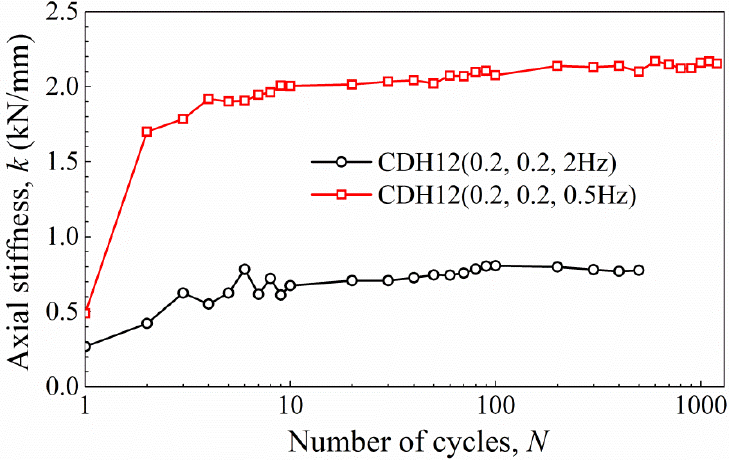
Figure 17. Developments of axial stiffness for different frequencies.